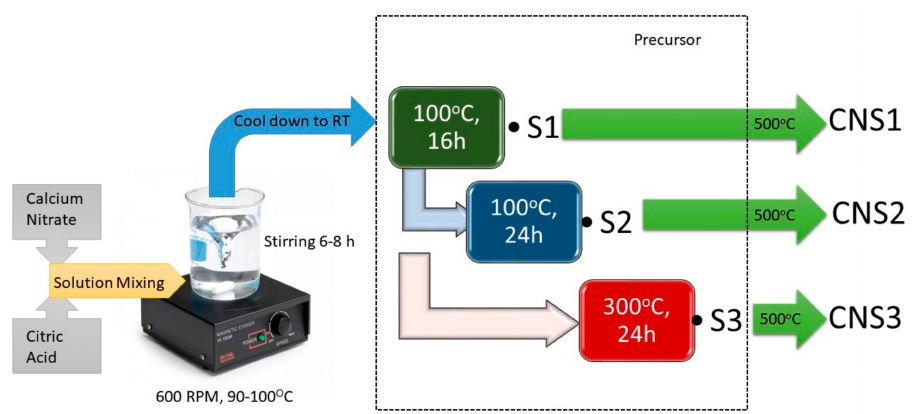
Figure 1. Synthesis of calcite nanocrystals CNS1, CNS2 and CNS3 using thermal schemes S1, S2 and